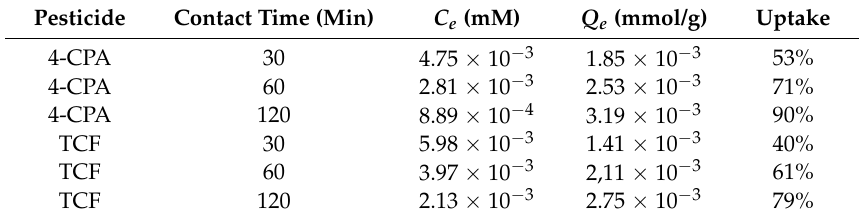
Table 8. Ce and Qe values for both pesticides and at different contact times with Fe 3 O 4 /NS.